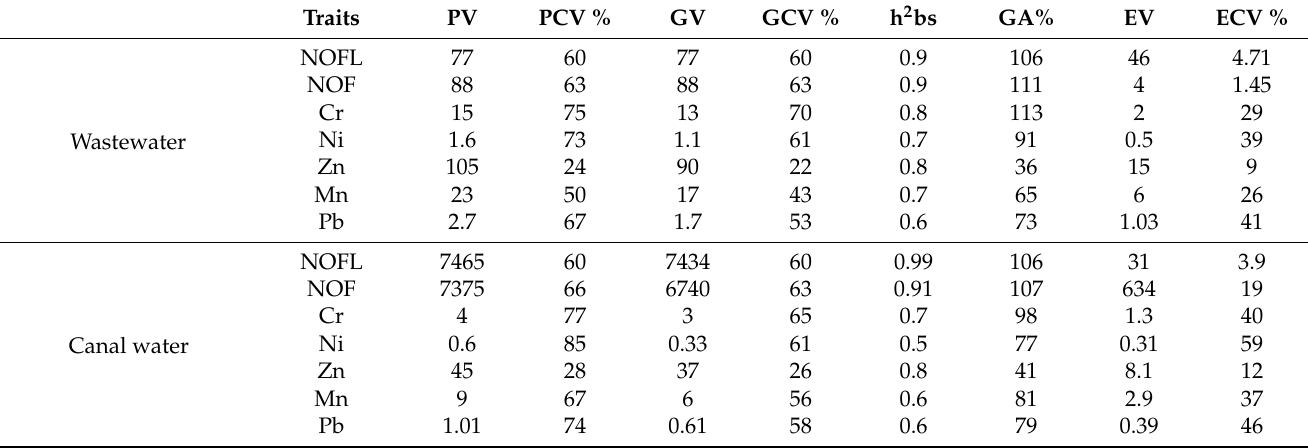
Table 3. Genetic components of variation for attributes related to yield and HM accumulation in tomato fruit irrigated with wastewater and canal